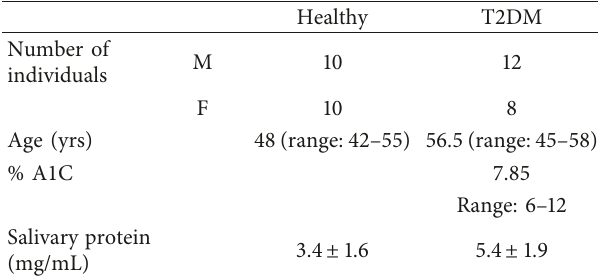
Table 1: Demographic characteristics, HbA1c, and total salivary protein